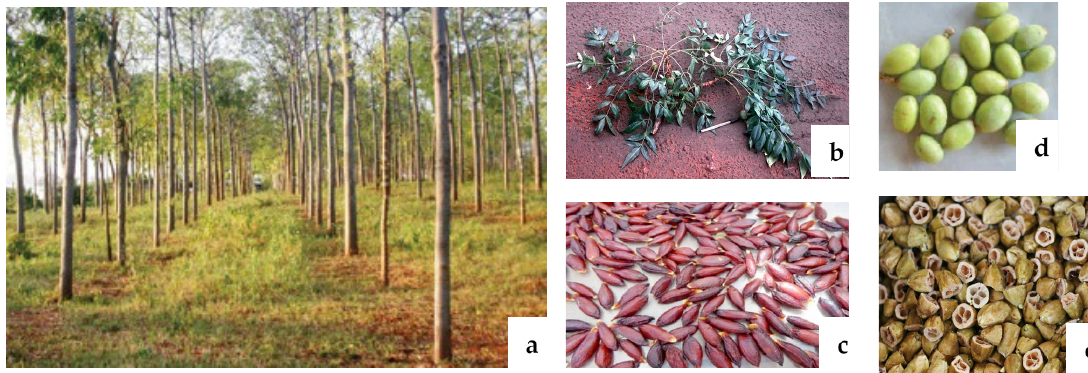
Figure 1. Melia volkensii and its various parts: ( a ) 10-year old M. volkensii plantation, ( b ) leaves, ( c ) seeds, ( d ) fruits and ( e ) nuts [23].